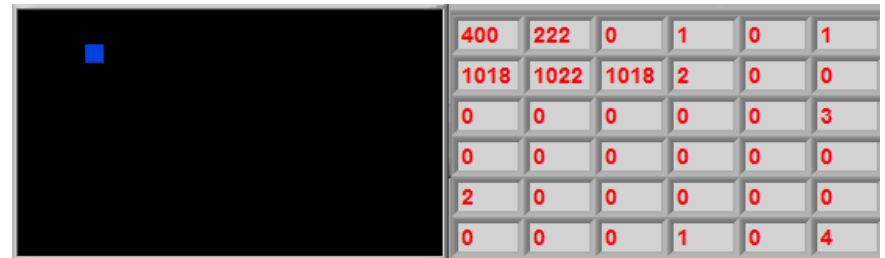
Figure 9. Center of mass of a tactile image.